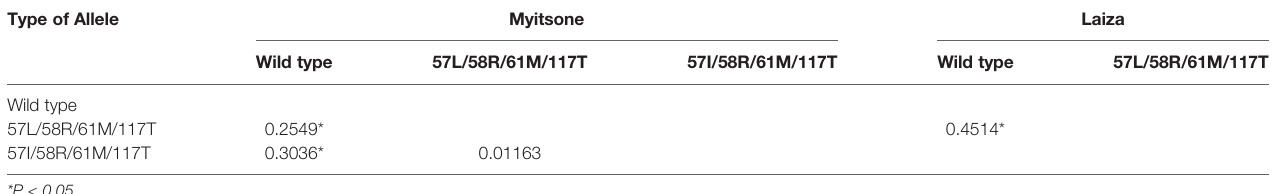
TABLE 5 | F ST values for allelecomparisonsbetween different genotypes, determined using microsatellites around dhfr of P. vivax population in two regionsof Myanmar. Type of